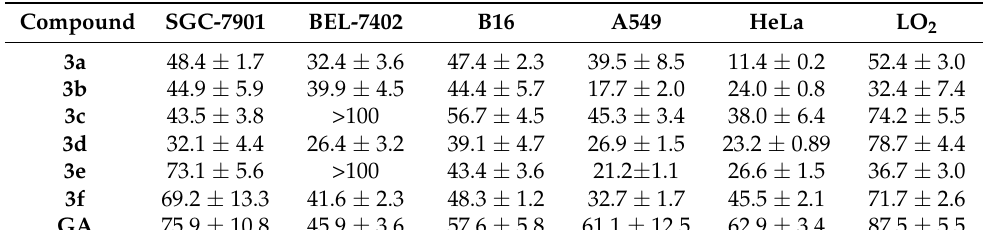
Table 1. IC 50 ( µ M) values of 3a – 3f toward the selected cancer cells for 48 h.